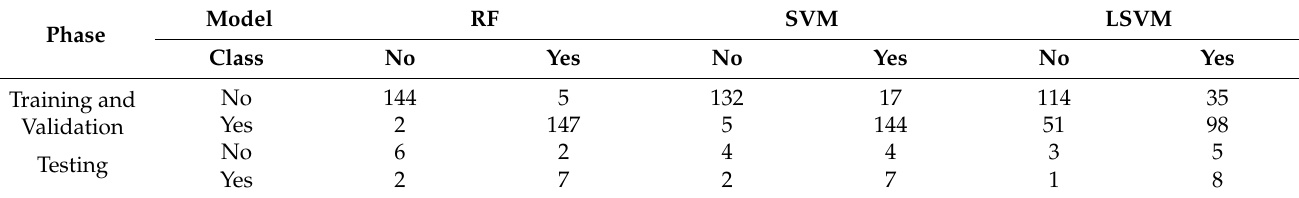
Table 11. Comparison of results from different models on the confusion